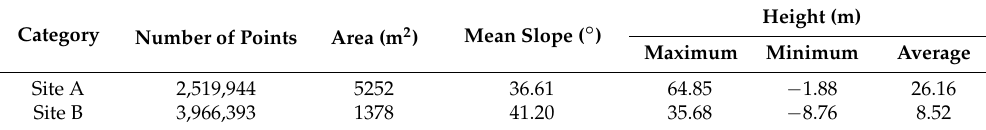
Table 1. Terrestrial laser scanning dataset statistics of study areas.